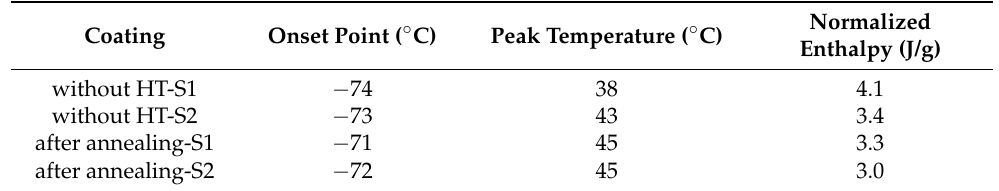
Figure 9. Integral calculation of the phase-transition enthalpy with TA Instruments software TRIOS based on the coating DSC curves: ( a ) ( b ) before annealing; ( c ) ( d ) after annealing. Table 6. Calculation results of the phase-transition enthalpy and temperature of the coatings before and after annealing.